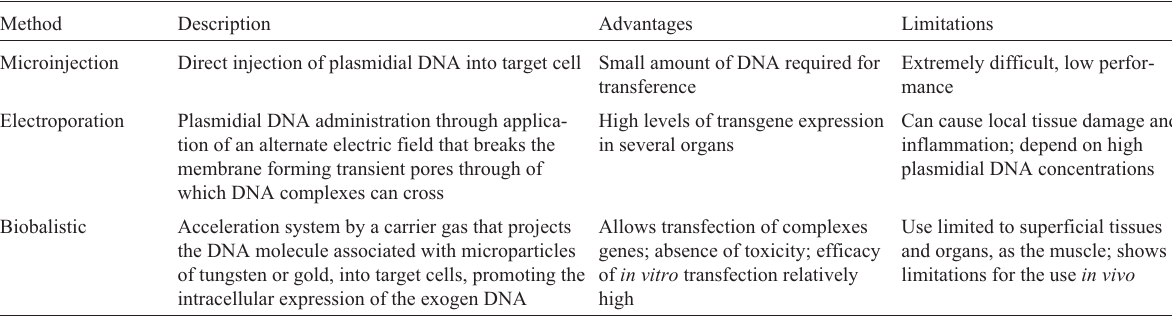
Table 1 - Physical methods of gene therapy with non-viral